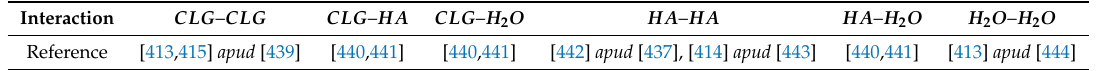
Table 4. Bibliographical references for interatomic potential function